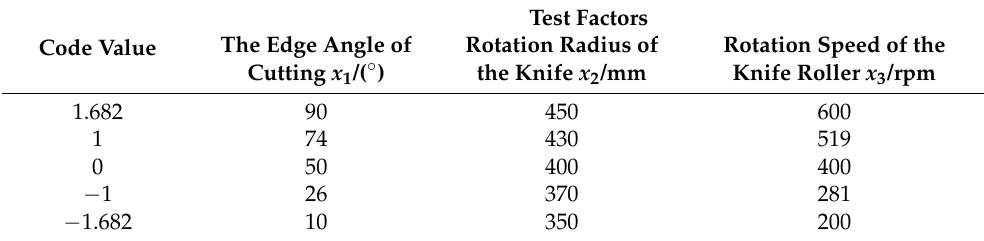
Table 1. Level coding table of the test